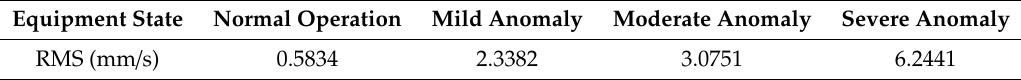
Table 7. The initial threshold of the online equipment in each state.